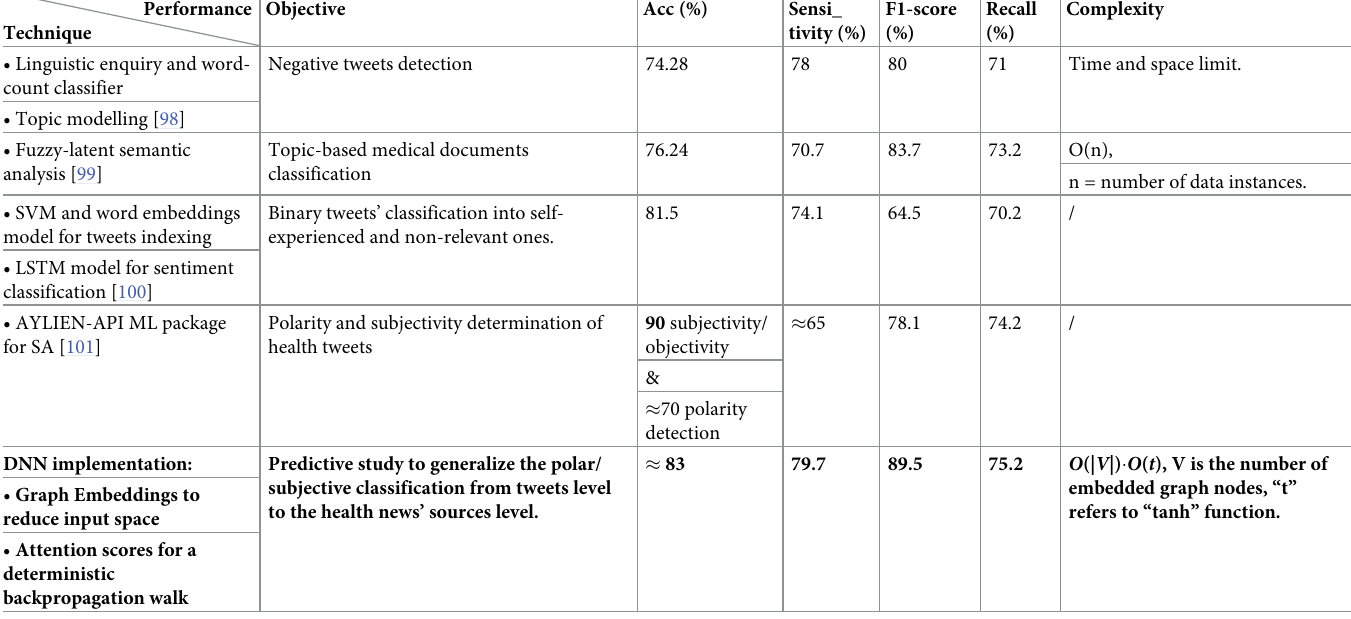
Table 8. Comparison of the proposed method (shown with bold) performance with other approaches on twitter health dataset. Performance